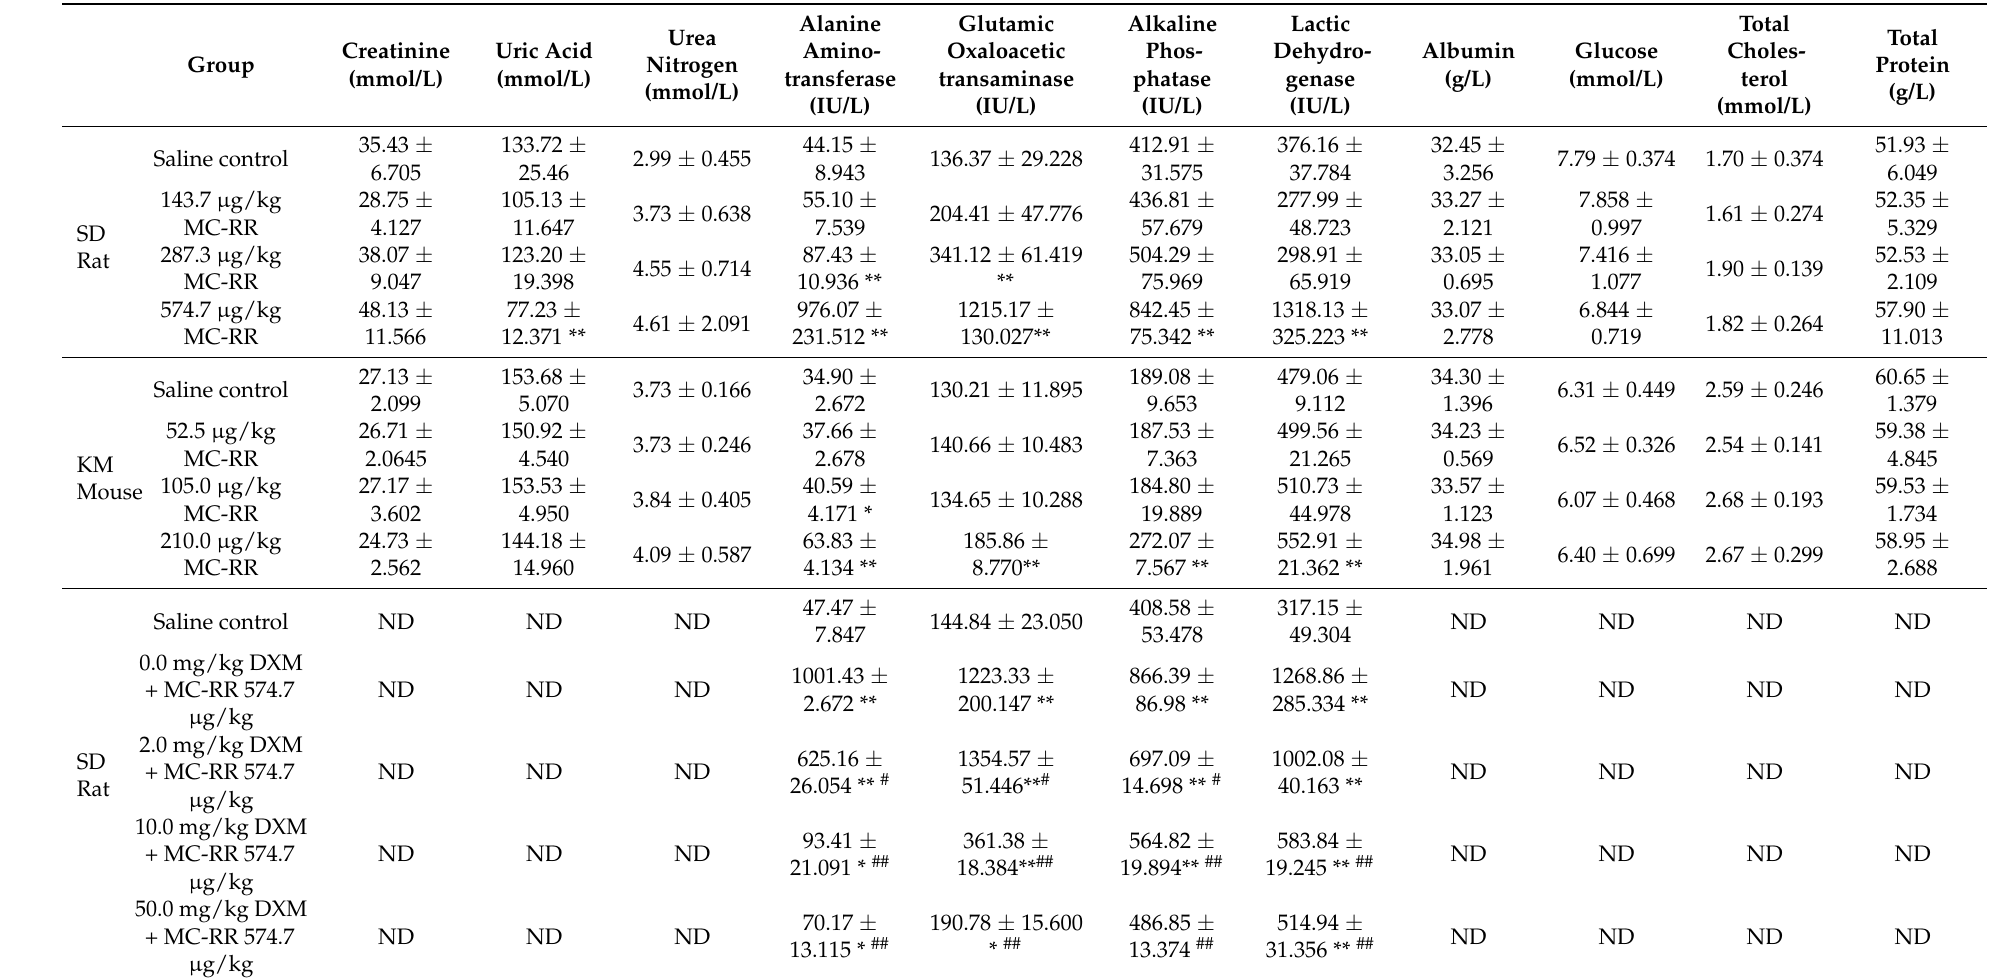
Table 5. Serum biochemical analysis of SD rats and KM mice treated with MC-RR in single dose experiment (mean ± SD, n =